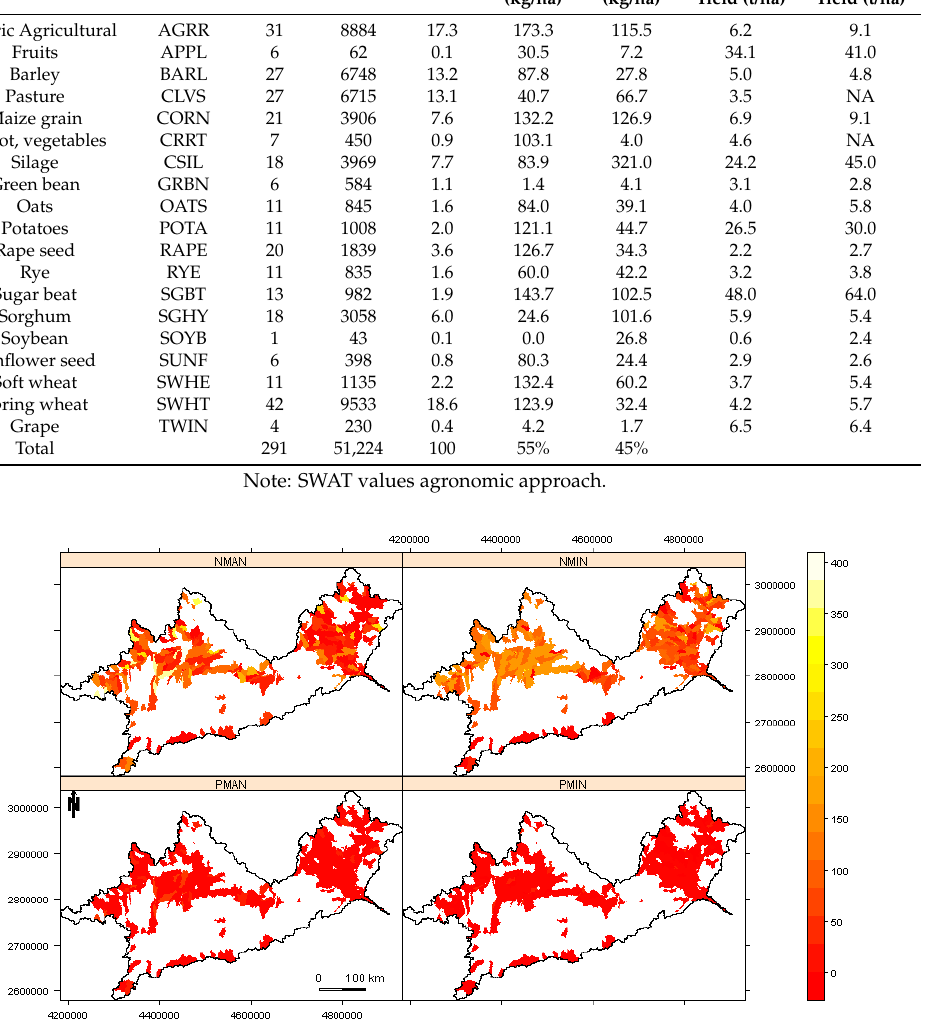
Figure 2. Map of applied fertilizations in SWAT (kg/ha). NMAN and PMAN: Nitrogen and Phosphorus in manure fertilizer, respectively; and NMIN and PMIN: nitrogen and phosphorus in mineral fertilizer, respectively.